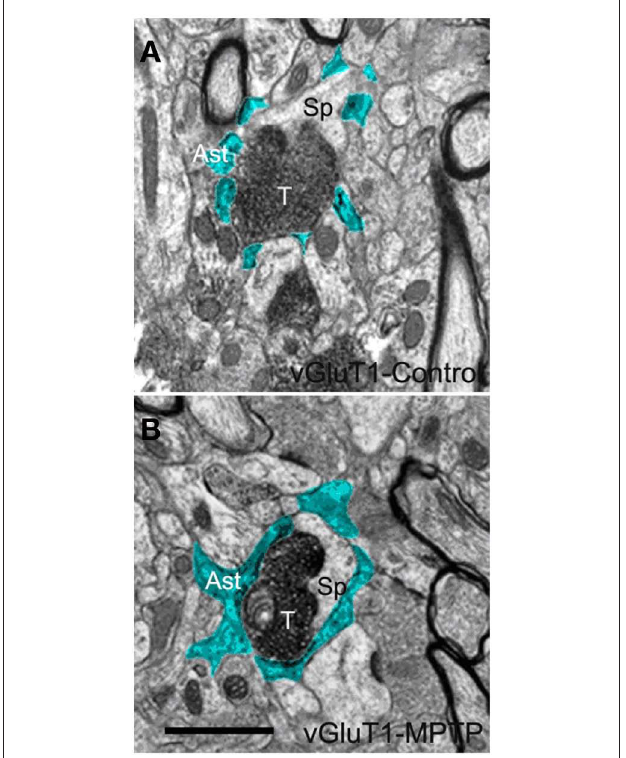
Figure 4 | Three-dimensional reconstruction of tripartite synapses (TS) formed by a vgluT1-immunoreactive terminal in the striatum of a control (A–C) and a MPTP-treated (A ′ –C ′ ) monkey. (A–C) In the TS of control animals, the perimeters of the axon-spinous interfaces were only partially surrounded by astroglial processes. (A ′ –C ′ ) TS vGluT1-containing synapses in MPTP-treated animals displayed a large increase in astroglial processes ensheathment. Abbreviations: Ast, astrocyte; PSD, post-synaptic density; Sp, dendritic spine; T,